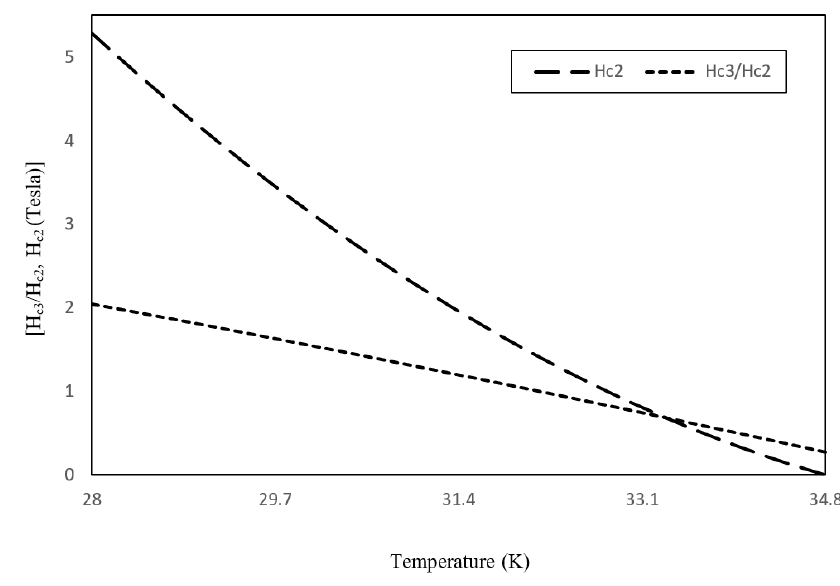
1.85 Sr 0.15 CuO 4 -a superconductor.